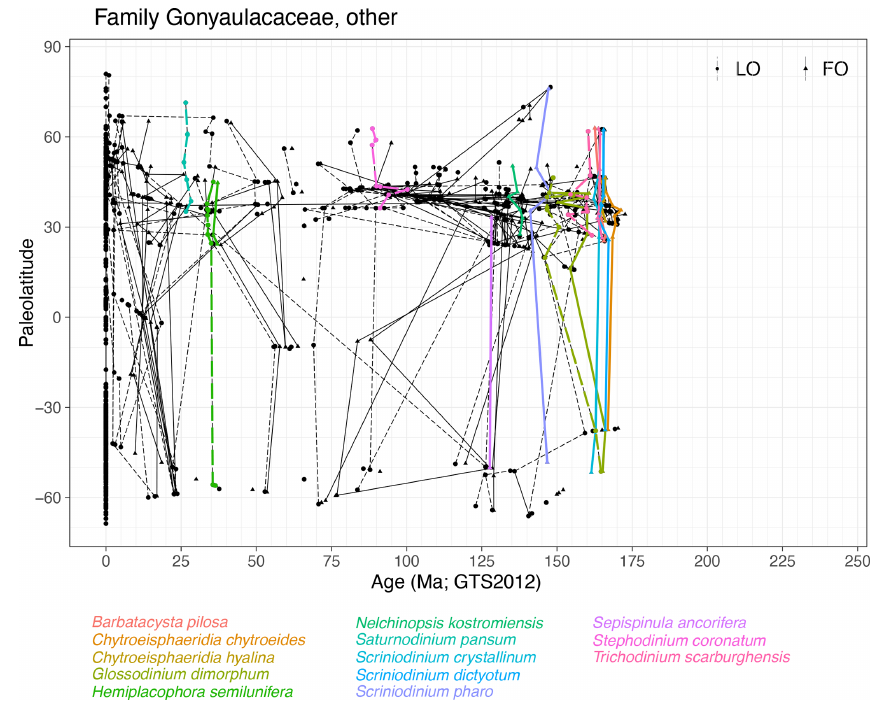
Figure 12. Same as Fig. 5 but for other genera in the family Gonyaulacaceae.